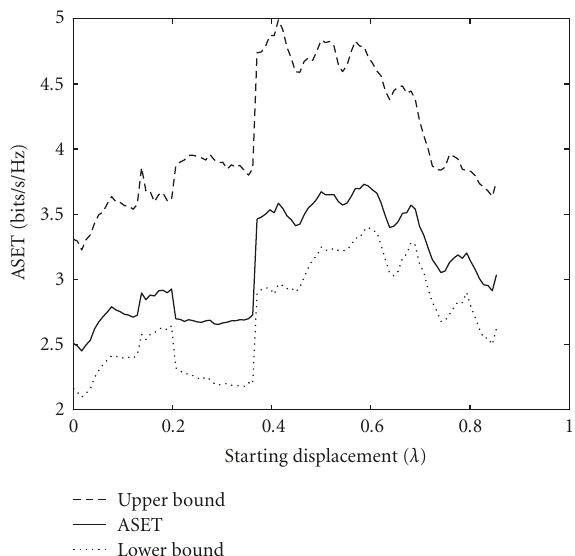
Figure 10: The average sample expected throughput (ASET) with upper and lower bounds for various initial displacements. The measured channel was used for a system with N t = 4, N r = 1, K = 6, and P =